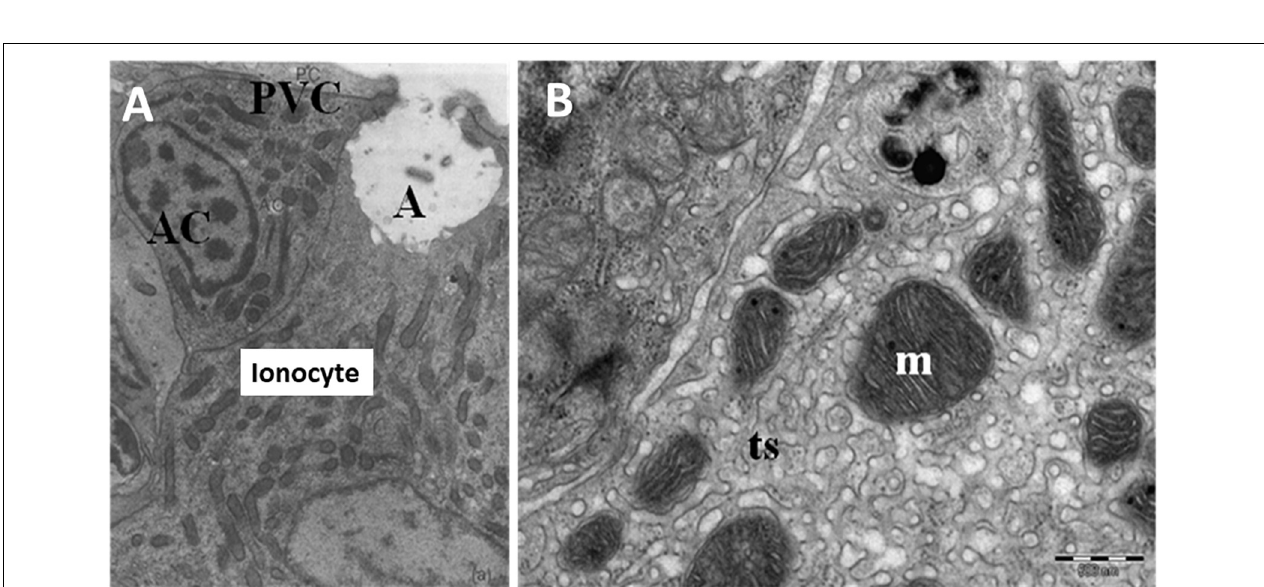
FIGURE 2 | Ultrastructure of ionocytes in freshwater adapted Oreochromis niloticus larvae. (A) A multicellular complex (MCC) formed by a mature ionocyte and an accessory cell (AC) sharing a single apical crypt (A) lying beneath a pavement cell (PVC). Reduced osmium staining; x 11,900 and (B) Detail of mitochondria with tubular system (m; mitochondria, ts; tubular system) (Bar = 500 nm) (Fridman, 2011).